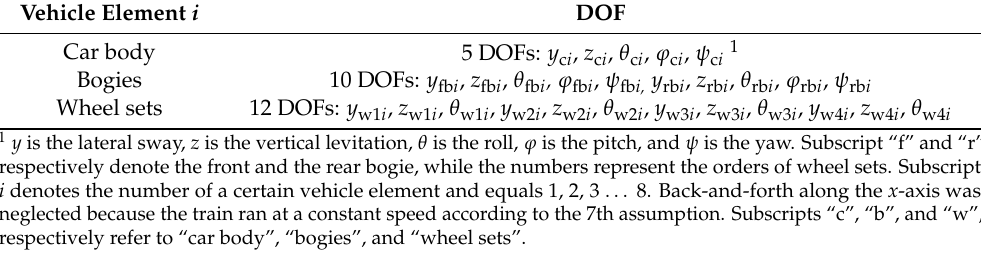
Table 1. The DOFs of a vehicle element. Vehicle Element i